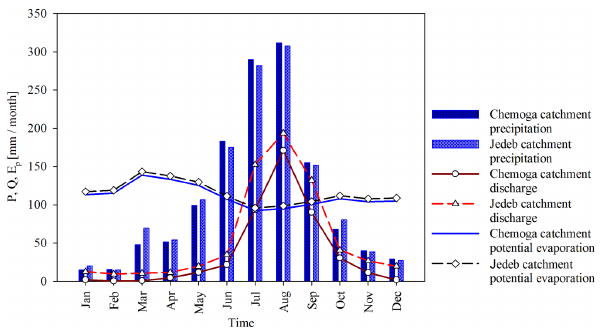
Fig. 2. Intra-annual variability of hydro-climate data for the period 2008-2010 showing Figure 2. Intra-annual variability of hydro-climate data for the pe- similar climate and distinct streamflow response in Chemoga and Jedeb catchments. P, Q and riod 2008–2010 showing similar climate and distinct streamflow re- E p in the y-axis stand for precipitation, discharge and potential evaporation, respectively. sponse in the Chemoga and Jedeb catchments. P , Q and E p on the y axis stand for precipitation, discharge and potential evaporation,